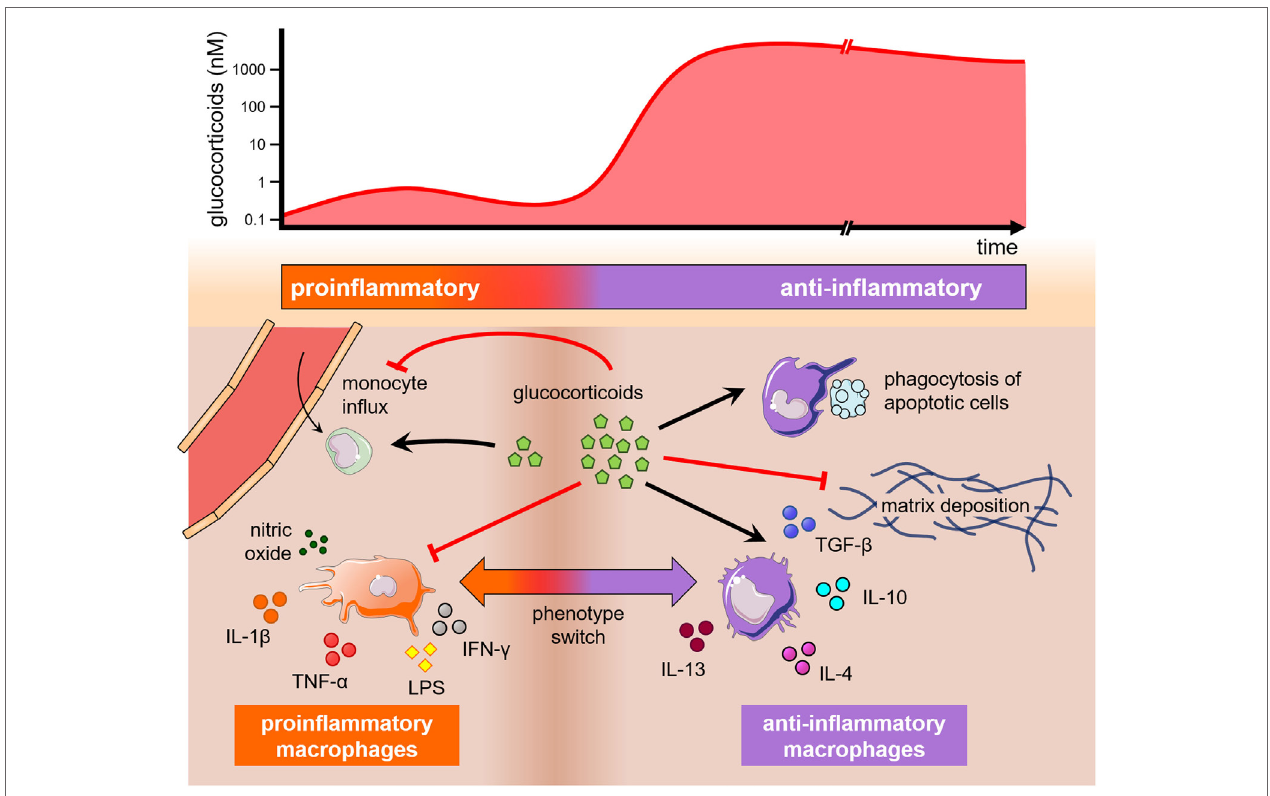
FiGURe 3 | The influence of glucocorticoids on monocytes and macrophages. Glucocorticoids may play opposing effects on monocytes and macrophages depending on theirs levels and time of exposure (top). A graphical representation depicts these effects on monocyte trafficking into tissues, macrophage polarization, and phagocytosis (bottom). A short and low increase in glucocorticoid levels (left) stimulates monocyte extravasation into the injured tissue, while high and long-lasting levels of glucocorticoids (right) inhibit monocyte proliferation and extravasation, as well as drive macrophage polarization into anti-inflammatory phenotypes that may produce extracellular matrix or stimulate the engulfment of apoptotic cells. All these phenomena are also influenced by cytokines present in the